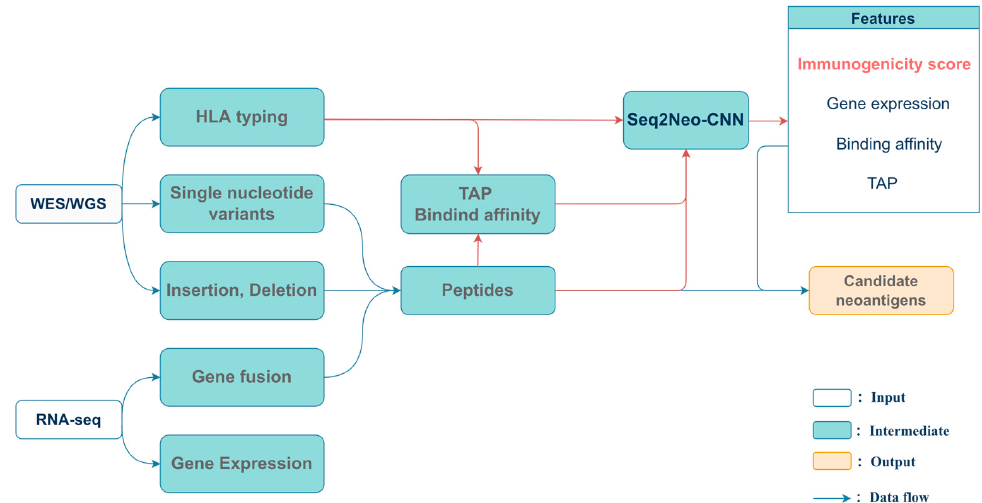
Figure 1. An overview of Seq2Neo. The input of Seq2Neo includes raw WGS, WES, RNA-seq or pep- tide information. Seq2Neo predicts various peptide features, including CNN-based immunogenicity score, peptide–HLA binding affinity, TAP transport efficiency and gene expression. Then, Seq2Neo uses those features to rank candidate